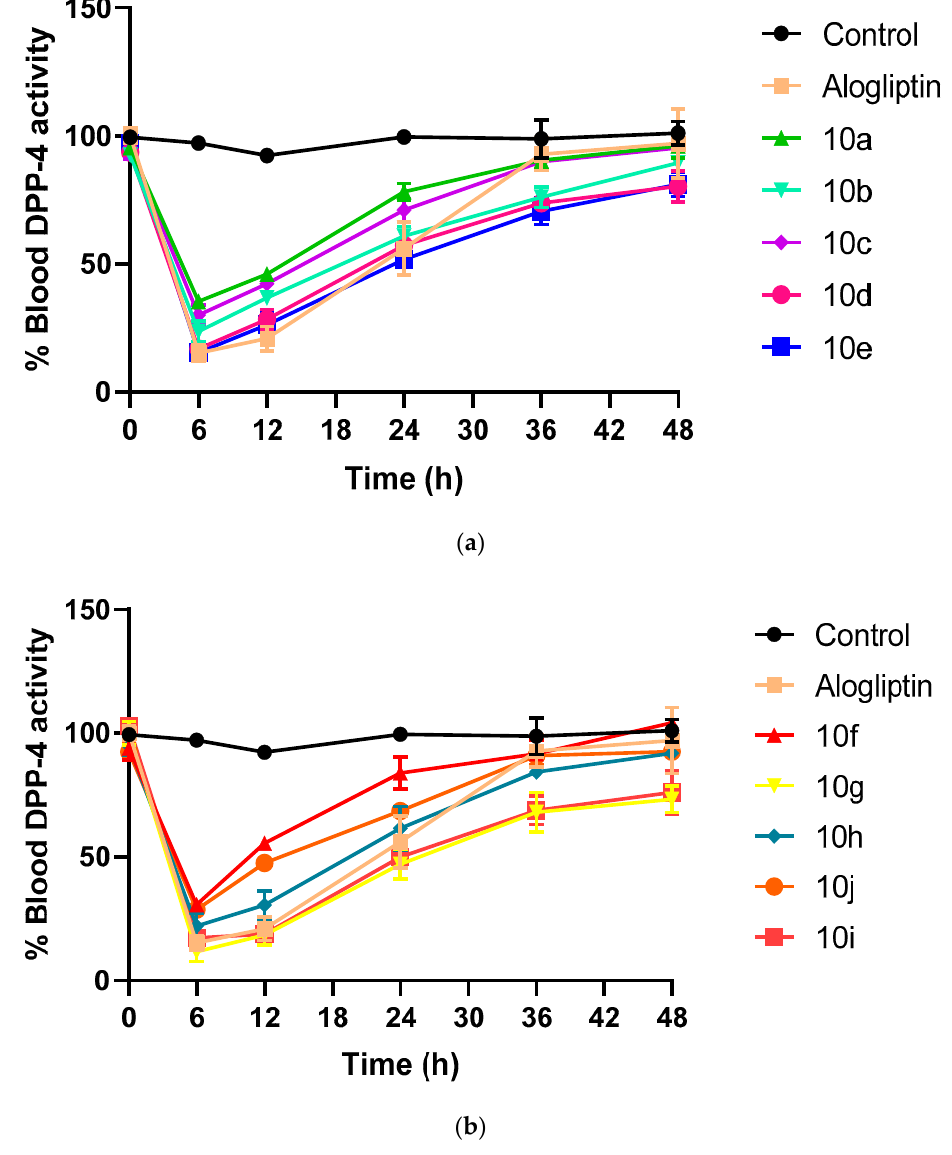
Figure 3. ( a ). The in vivo DPP-4 activity of 10a–e hybrids and alogliptin within 48 h. ( n = 3). ( b ) The in vivo DPP-4 activity of 10f–j hybrids and alogliptin within 48 h. ( n =